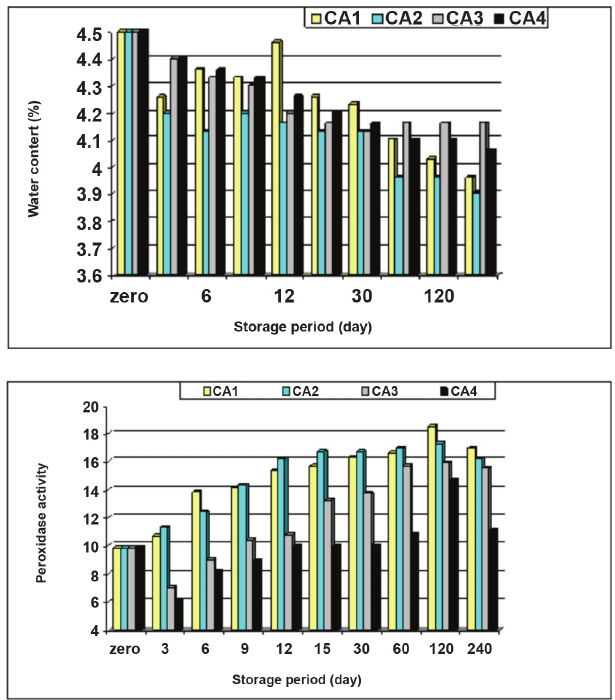
Figure 3: Effect of the interaction between storage temperature (A, room temperature and B, cold temperature), controlled atmosphere and exposure period on water content of onion seeds stored for 12 months. For more details about CA1 to CA4: CA1: 4 % CO 95.5 % N and 0.5 % O 2, 2 2 CA2: 8 % CO 91 % N and 1 % O 2, 2 2 CA3: 16 % CO 82 % N and 2 % O 2, 2 2 CA4: 24 % CO 73 % N and 3 % O 2, 2 2